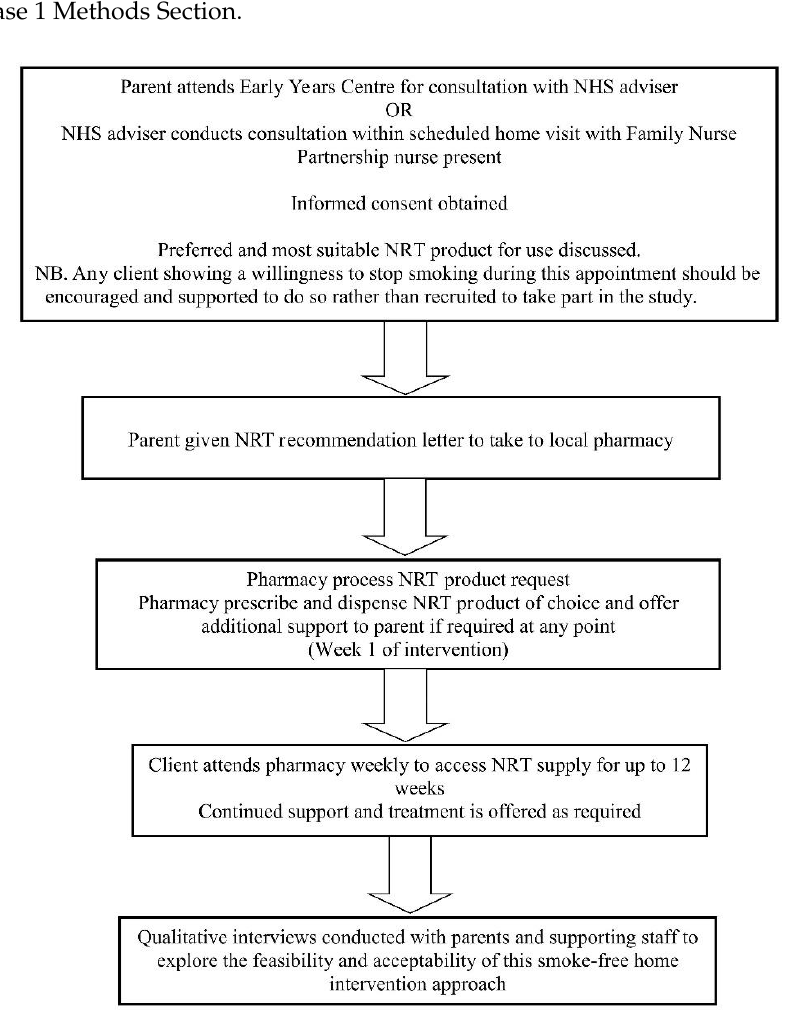
Figure 1. Phase 2 study design. Abbreviations: NHS—National Health Service; NRT—Nicotine replacement therapy.